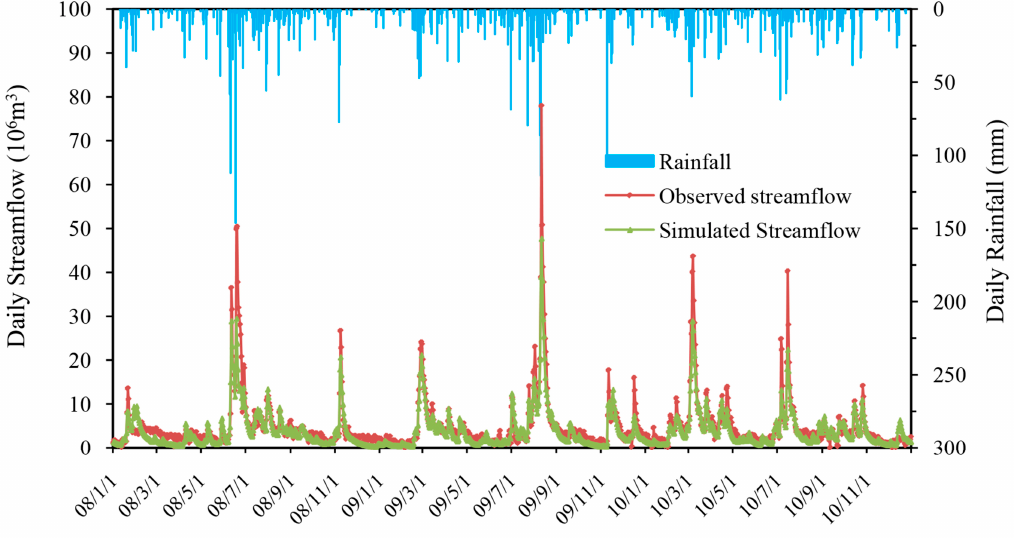
Figure 6. Comparison between simulated and observed daily streamflow in the Xitiaoxi watershed during the validation period (1 January 2008–31 December 2010).